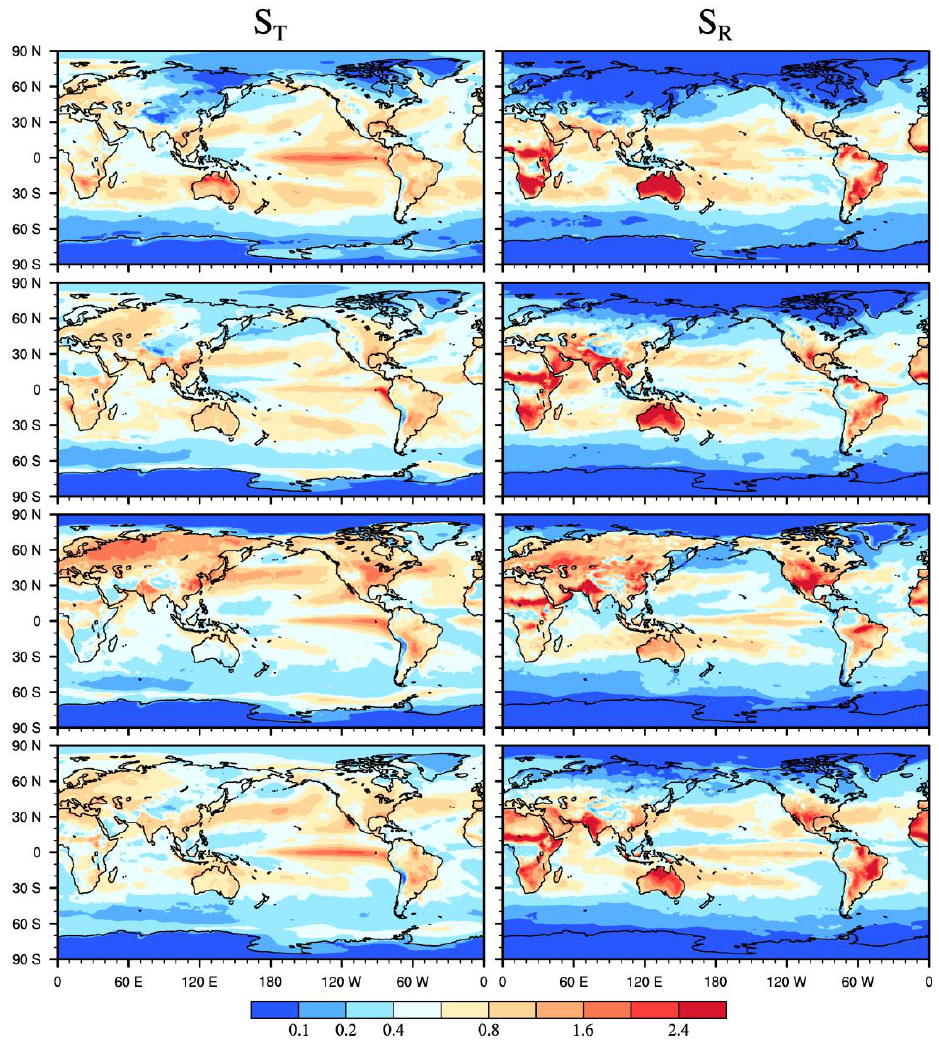
Figure 6. Distributions of the S T and S R . The unit is hPa. The rows from top to bottom are correspond to January, April, July, and October respectively.